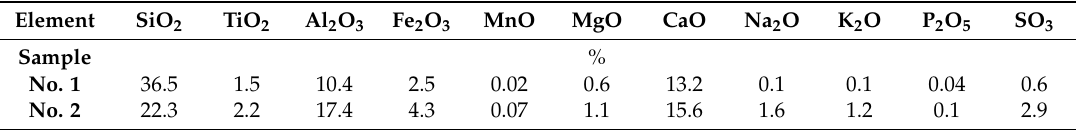
Table 1. Elemental analysis of fly ash carried out by XRF standardless analysis, values calculated to oxide form (the results have not been normalized to